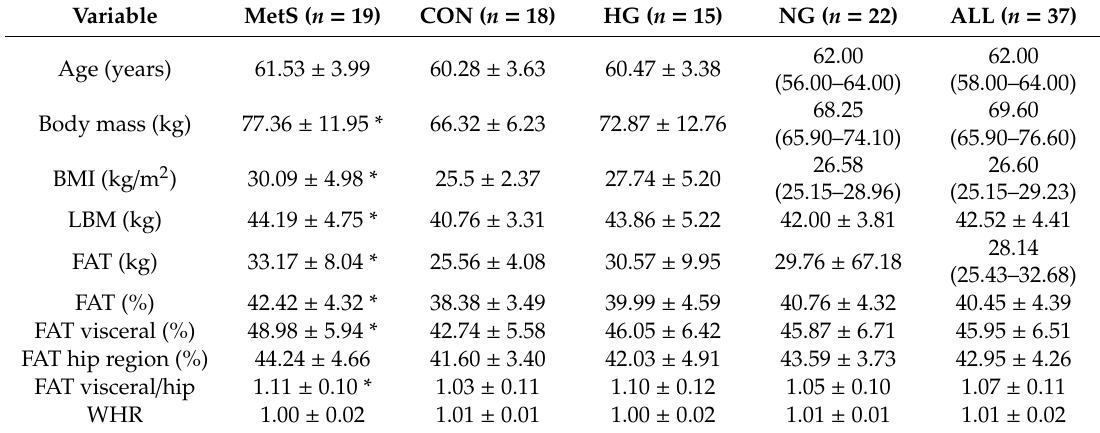
Table 1. Age and body composition in the groups under study.